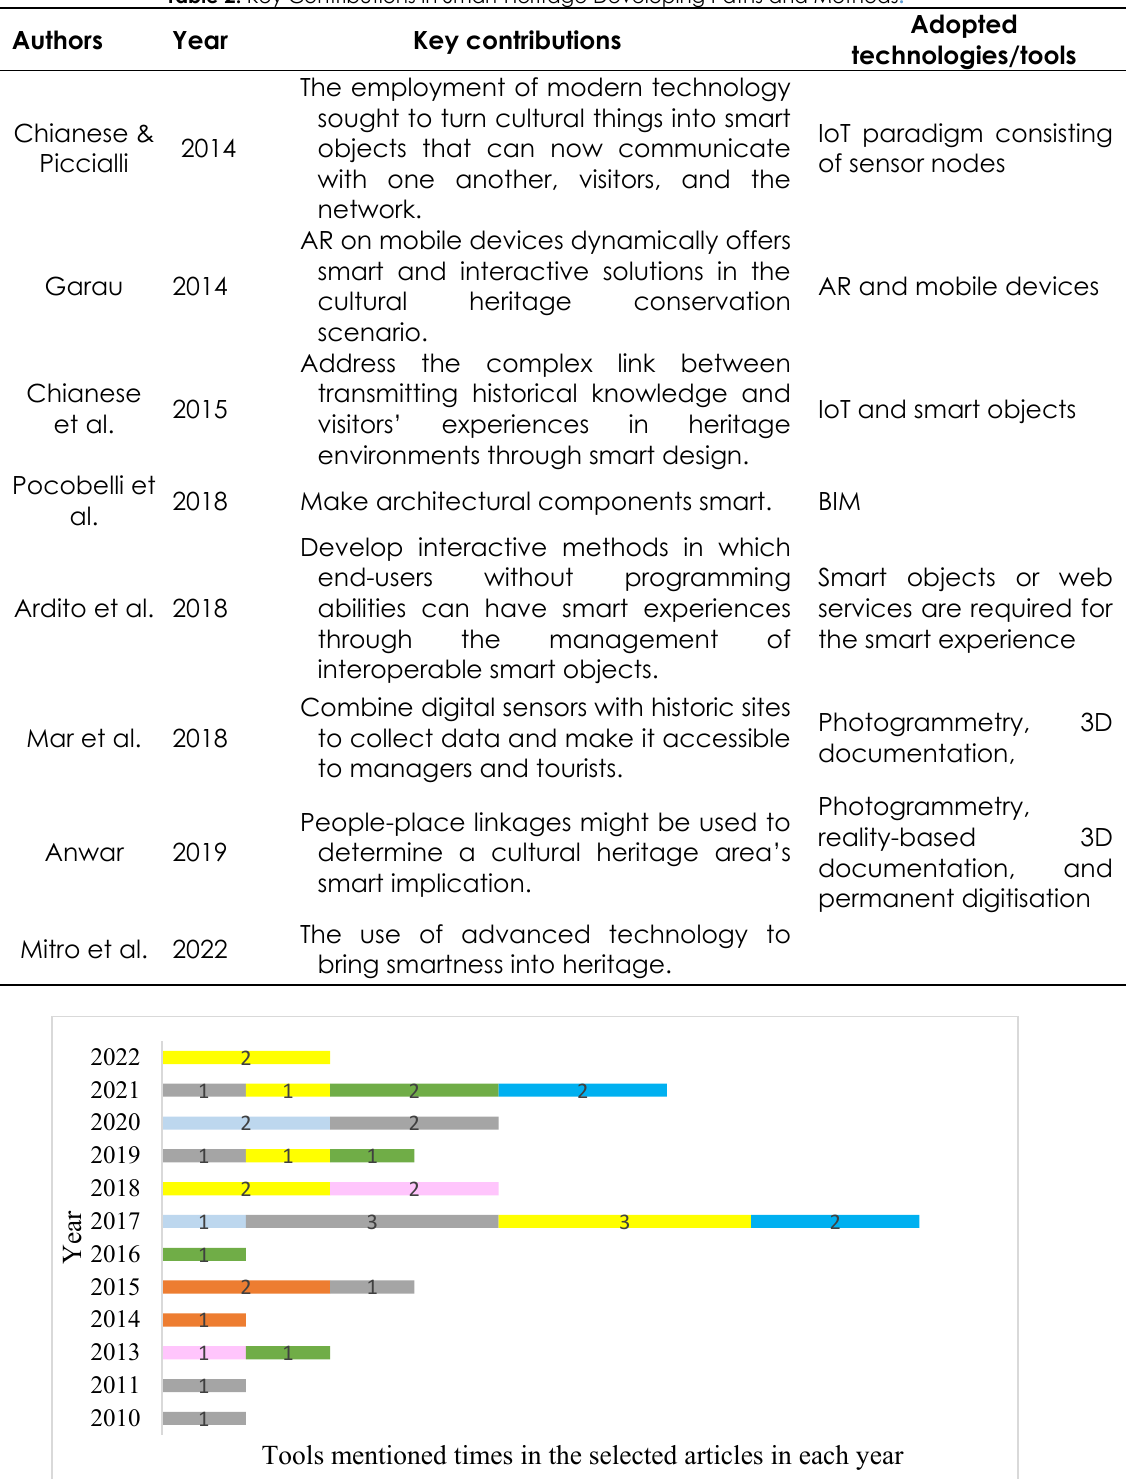
Table 2. Key Contributions in Smart Heritage Developing Paths and Methods .